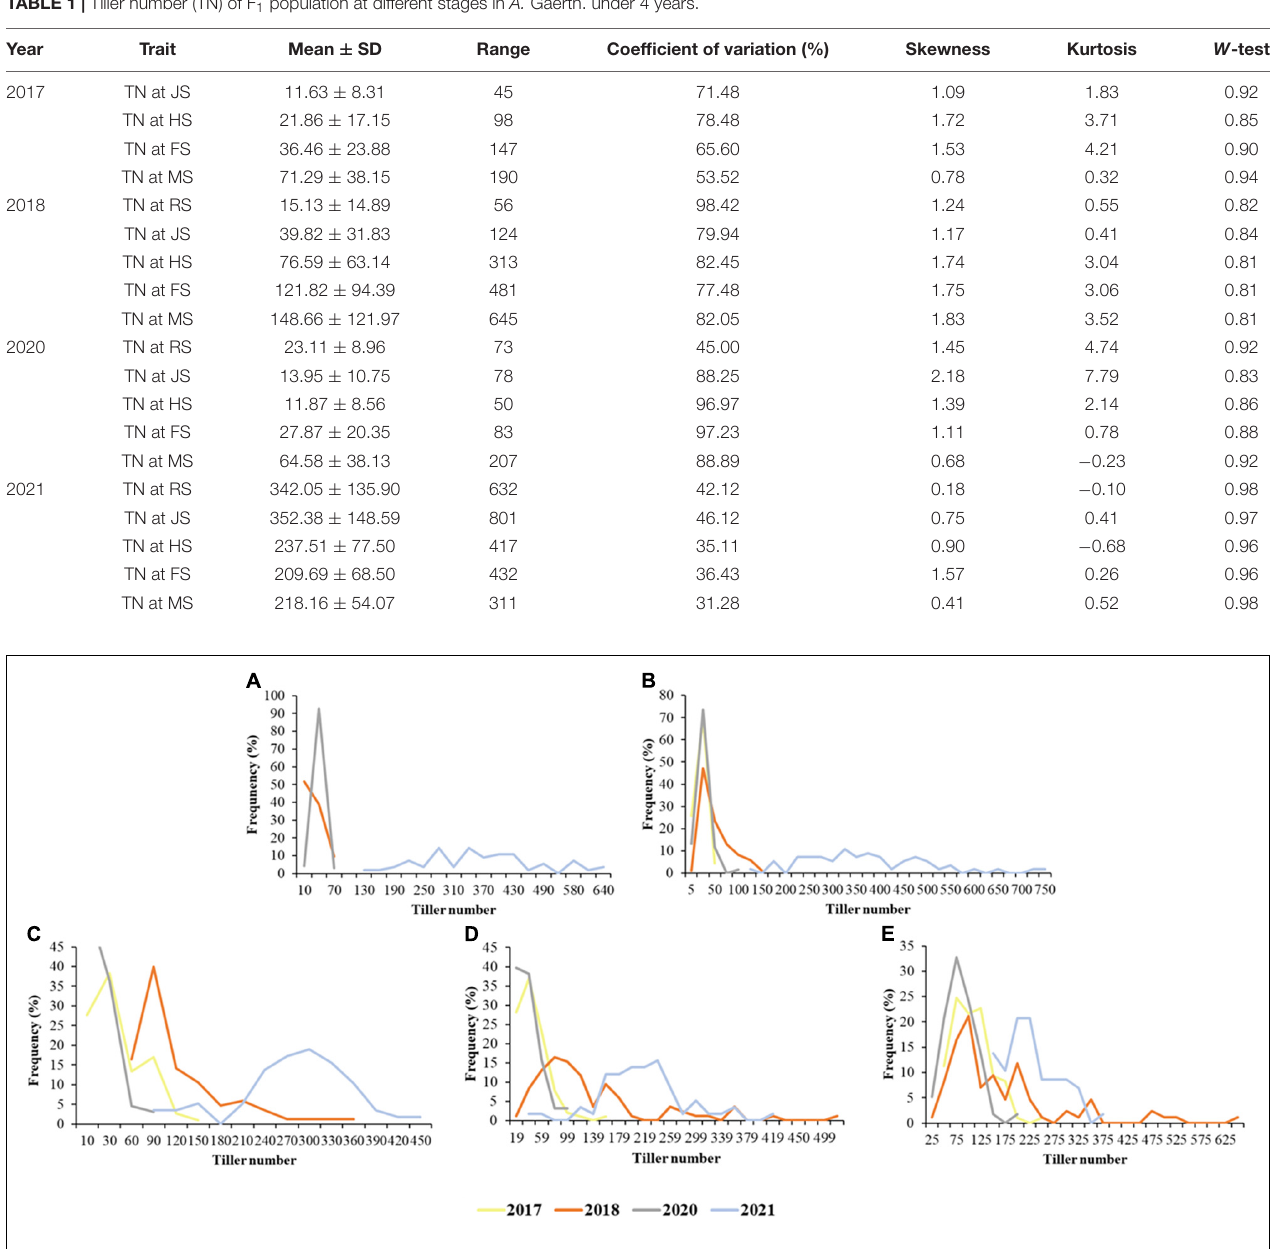
FIGURE 1 | Frequency of tiller number (TN) at different stages in the Agropyron cross-pollinated (CP) population in 4 years. (A–E) Were the frequency of TN at the recovering stage (RS), jointing stage (JS), heading stage (HS), flowering stage (FS), and maturity stage (MS), respectively; the different colors for the different years.